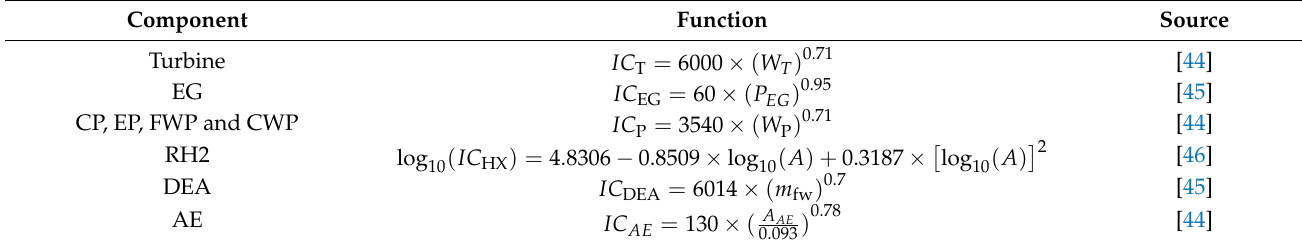
Table 17. Estimation function for the cost of partial components.